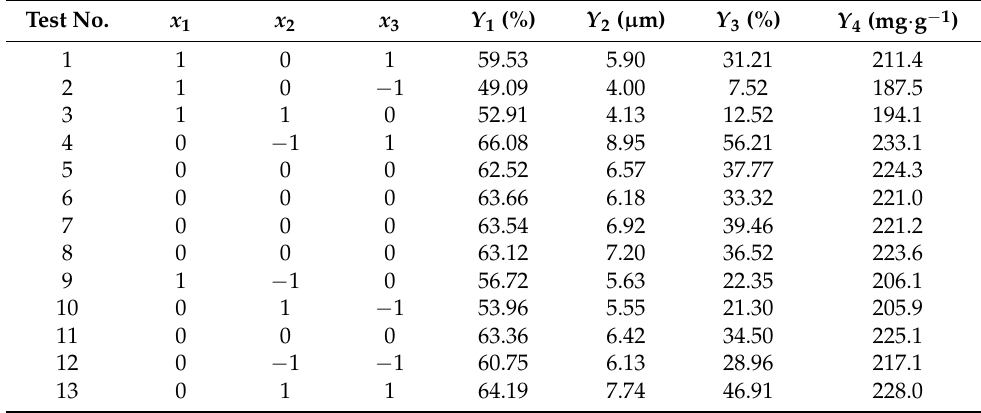
Table 2. Experimental results of Box–Behnken design for the response variables. Test